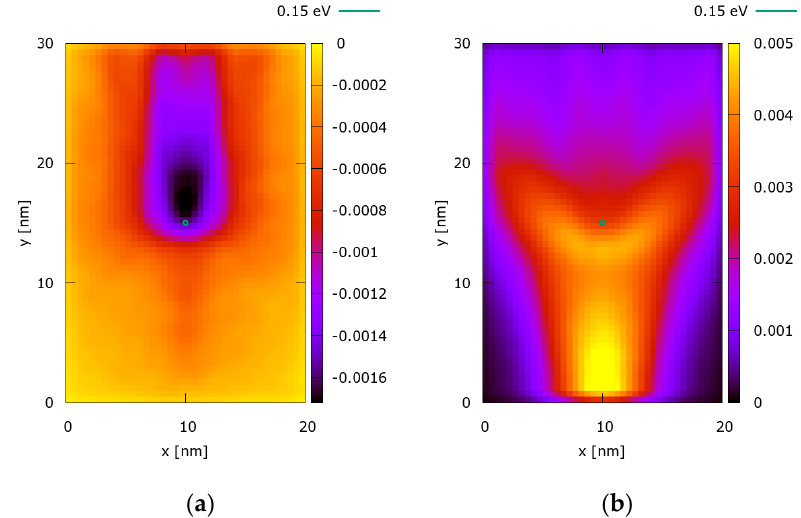
− ( 𝑥, 𝑦 ) and ( b ) the positive part 𝑓 ( x , y ) and ( b ) the positive part f + w xy 𝑤 𝑥𝑦